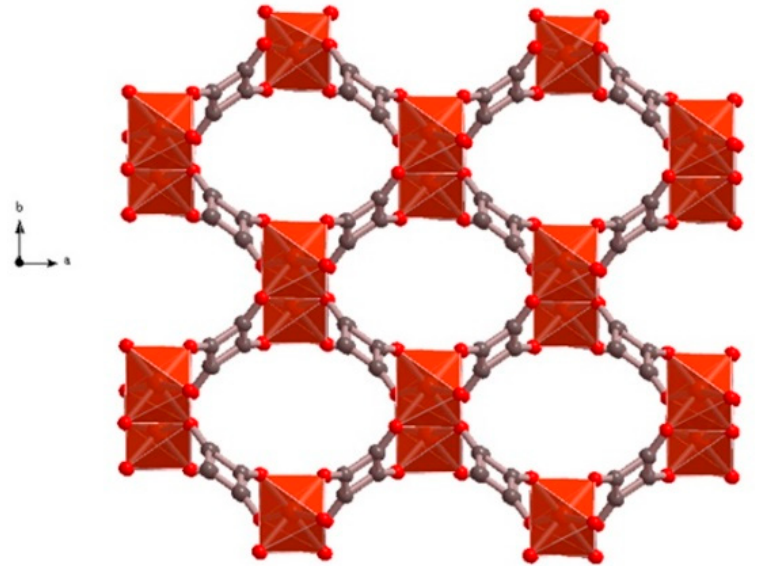
Figure 1. Computed crystal structure of copper squarate: view of a 2 × 2 × 2 supercell from [0 0 1] direction. Color code: Cu—orange; C—gray; O—red.